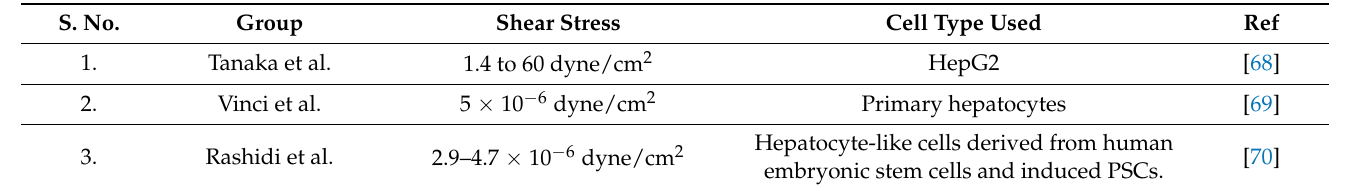
Table 1. Studies that have used liver ‐ on ‐ chip configurations with shear stress to mimic the na ‐ tive liver sinusoid enlisted. (PSC ‐ Pluripotent Stem Cells) S. No.